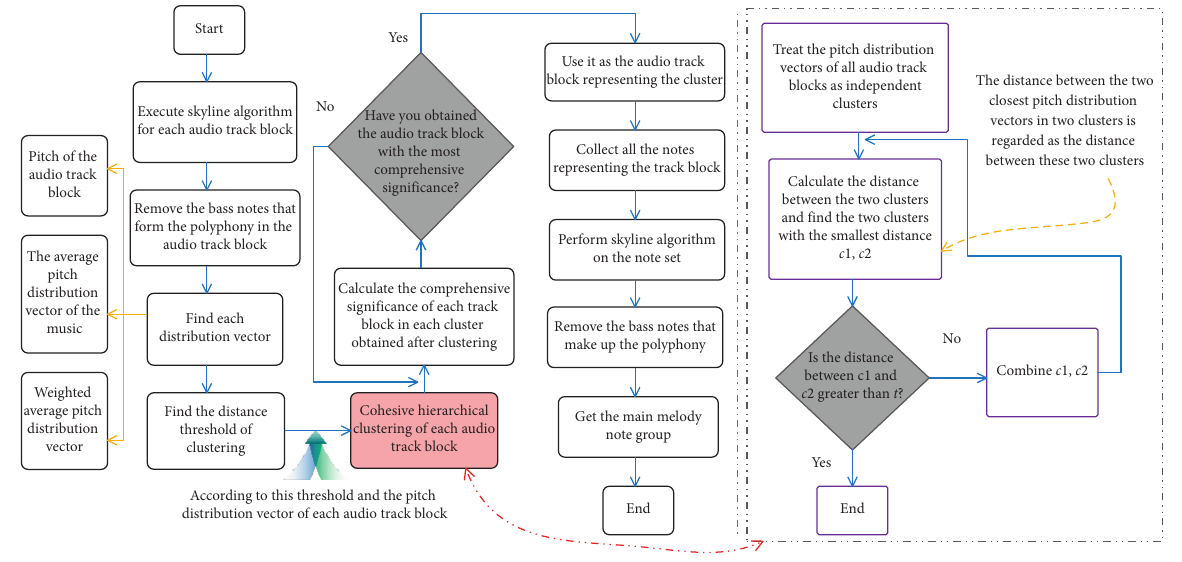
Figure 1: MTC algorithm